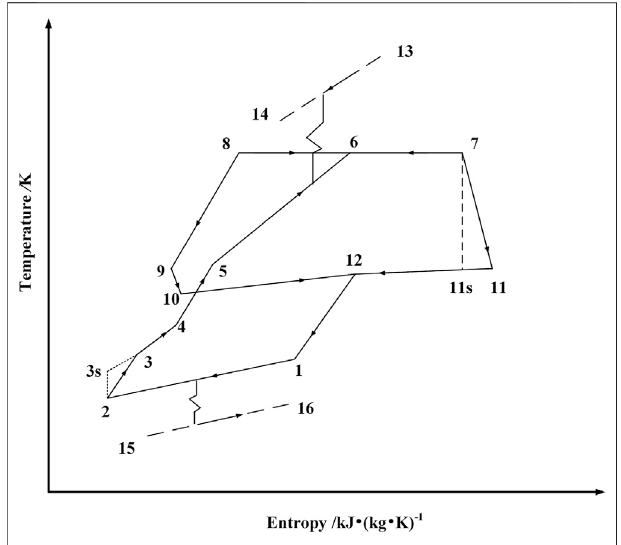
FIGURE 2 | T-s diagram of the original KCS